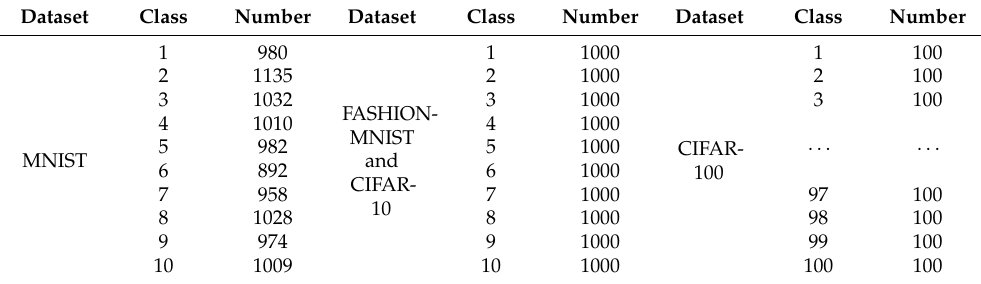
Table 2. The class number of the testing sets.